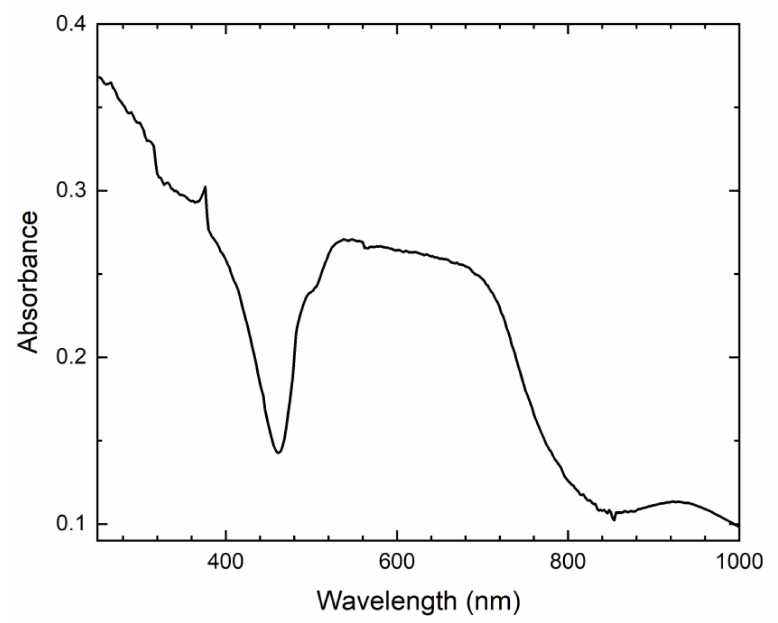
Figure 19. The absorption spectrum of vladimirivanovite (Sample 7).